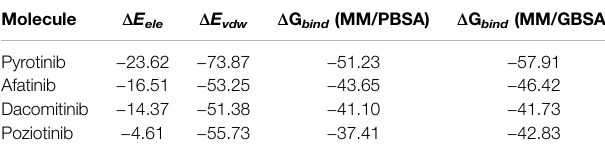
TABLE 4 | Binding energy of HER2 -targeted TKIs towards HER2 ex20ins variant A775_G776insYVMA. Molecule Δ E